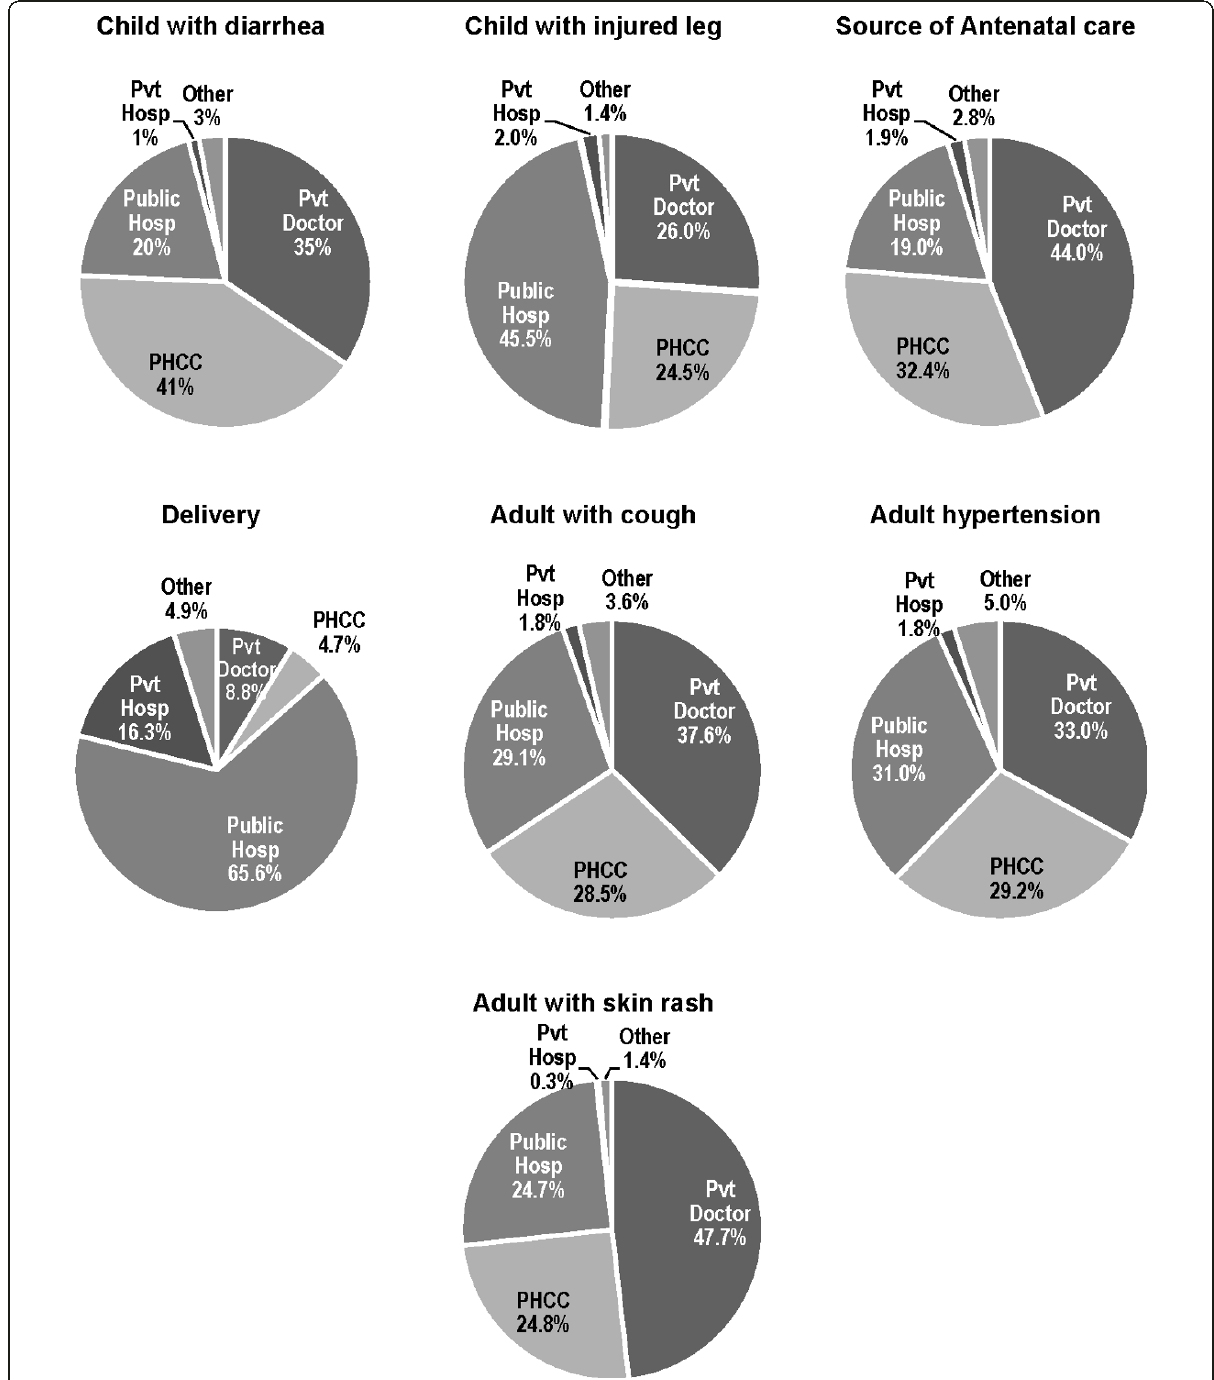
Figure 1 Treatment locations recommended by householders for various conditions suggested